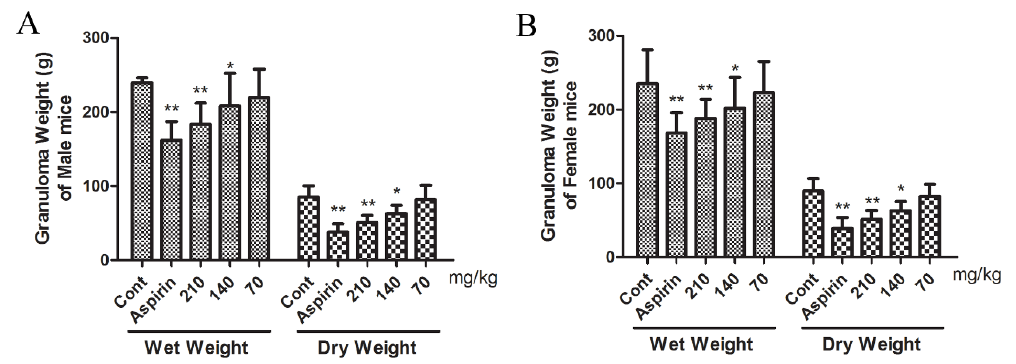
Figure 4. Effect of β -EA on Cotton Pellet Induced Granuloma Formation ( n = 5). ( A ) Granuloma weight of male mice. ( B ) Granuloma weight of female mice. * p < 0.05, ** p < 0.01, significant difference from the control group.